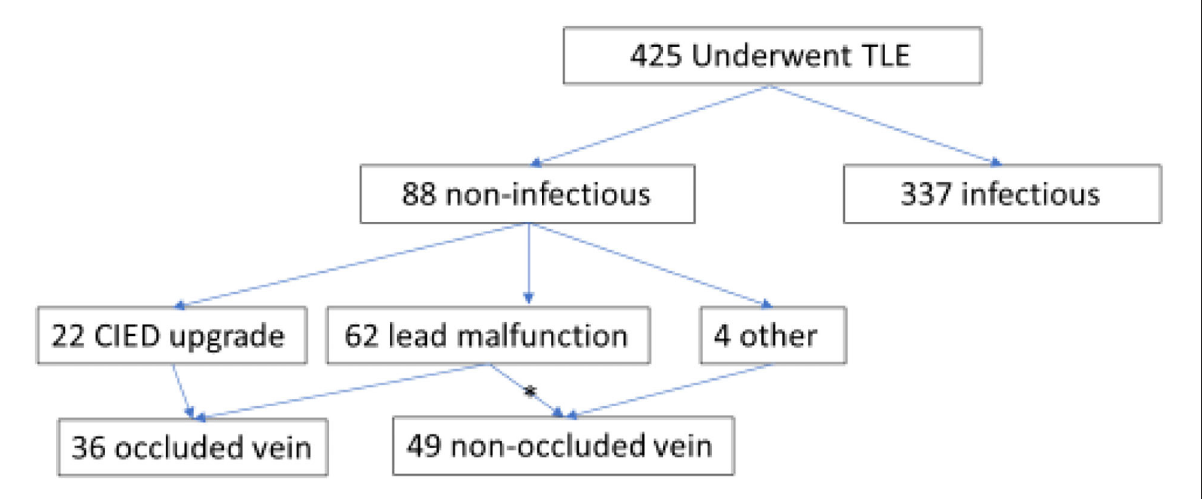
FIGURE1 Study design. * 3 status of vein occlusion